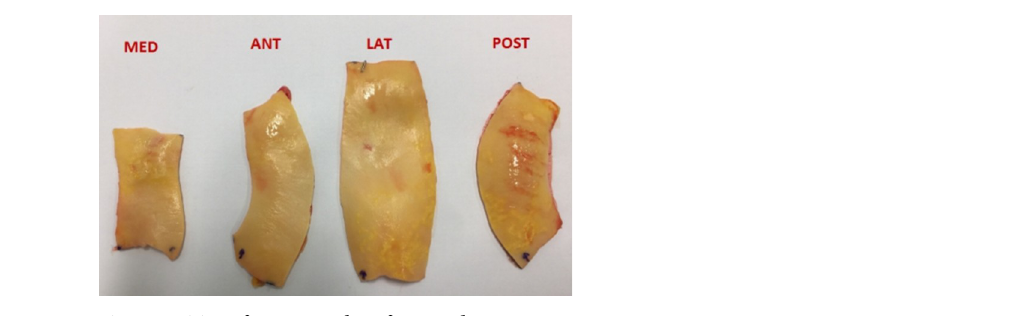
Fig 5. Partition of aorta sample to four quadrants.